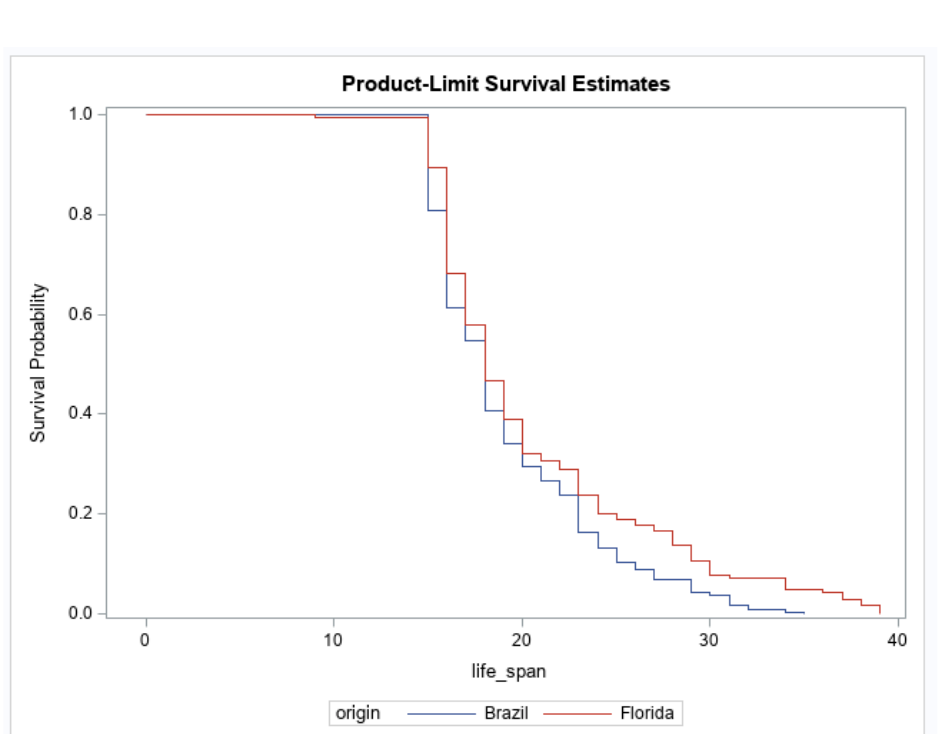
Figure 1. Female survival for Aedes aegypti originating from Brazil and Florida. Survival probabilities combine mosquitoes fed uninfected (control) and Mayaro virus-infected blood (Brazil, n = 214, Florida, n = 180).